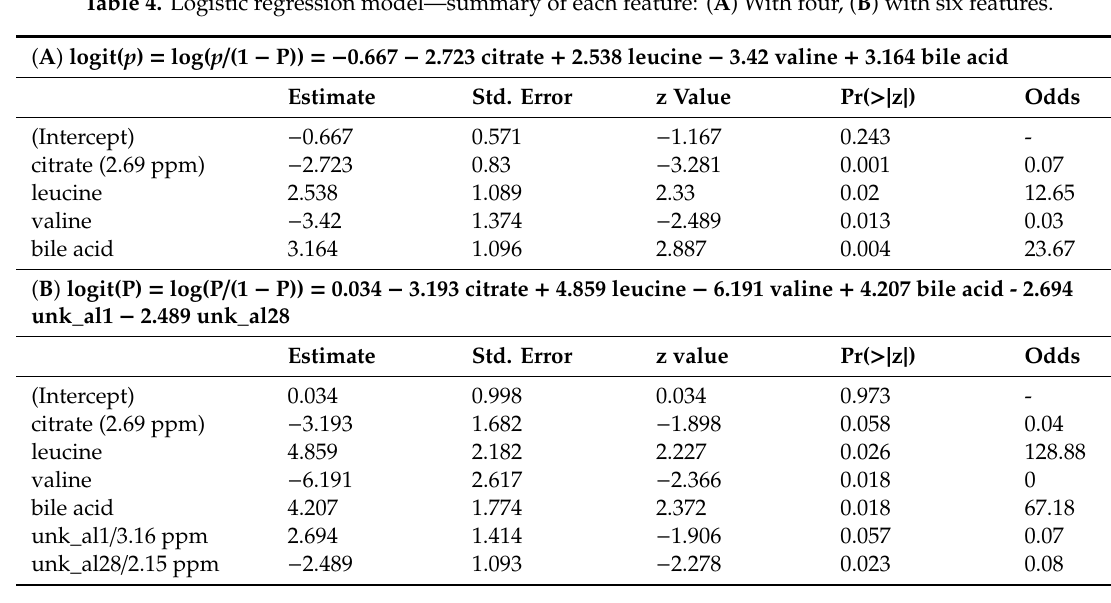
Table 4. Logistic regression model—summary of each feature: ( A ) With four, ( B ) with six